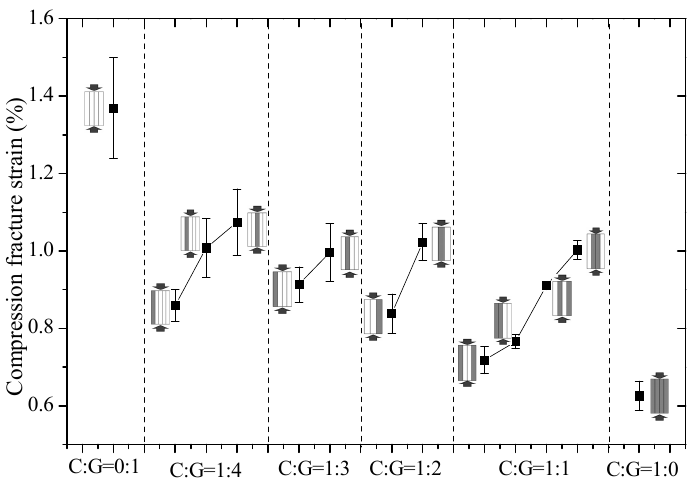
Figure 4. Compression fracture strain of different stacking sequences with various C/G ratios.